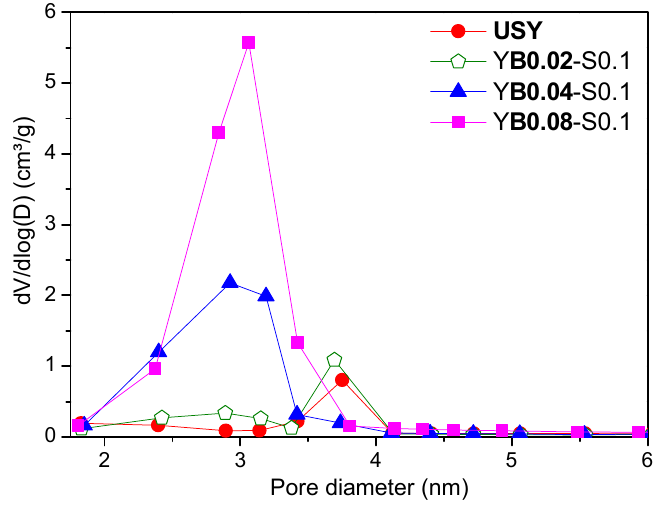
Figure 10. Pore size distributions obtained using the BJH method applied to the isotherms (desorption branch) for the original zeolite and the modified zeolites produced using different base concentrations.